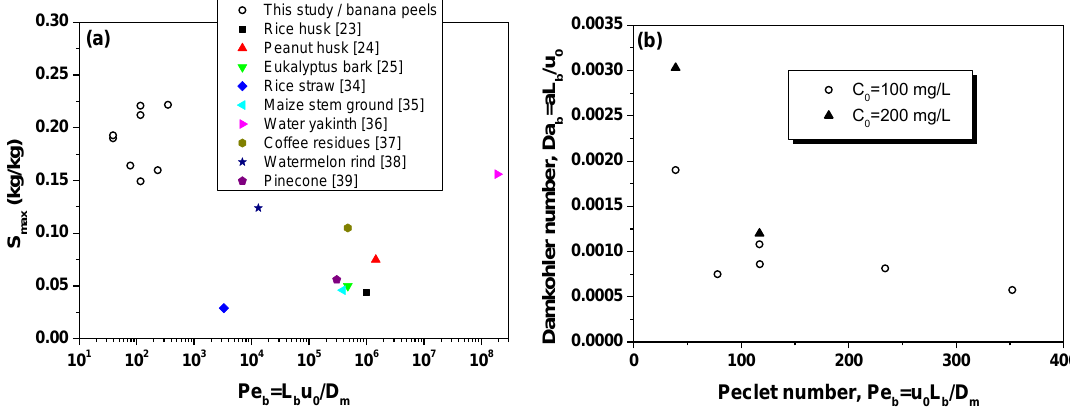
Figure 8. ( a ) Maximum MB sorption capacity of BP bed as function of Peclet number, as compared with that of other biosorbent beds from earlier studies; ( b ) Variability of kinetic sorption constant of BP bed (Damkohler number) as a function of Peclet